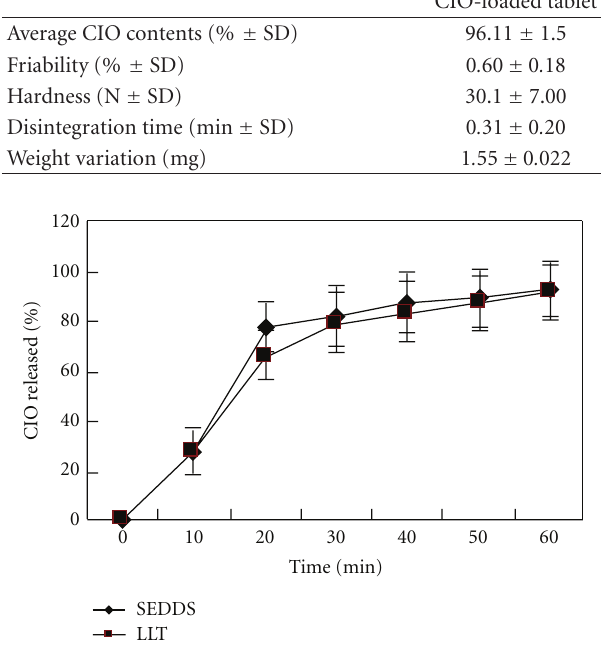
Figure 2: Drug release profiles of the SEDDS and LLT.